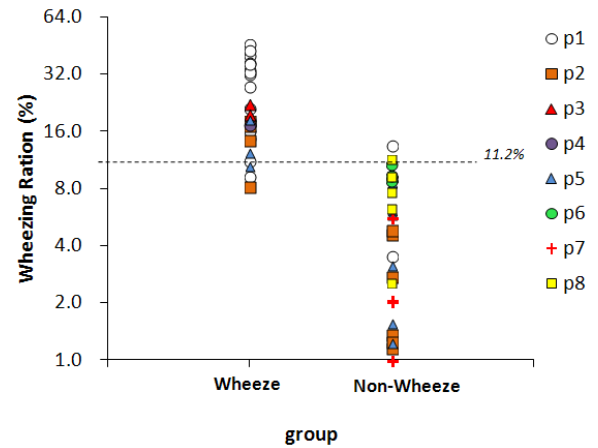
Figure 7. WR results for wheeze and non-wheeze sound files. p1~p8 refer to individual subjects. Dashed line indicates threshold for wheeze